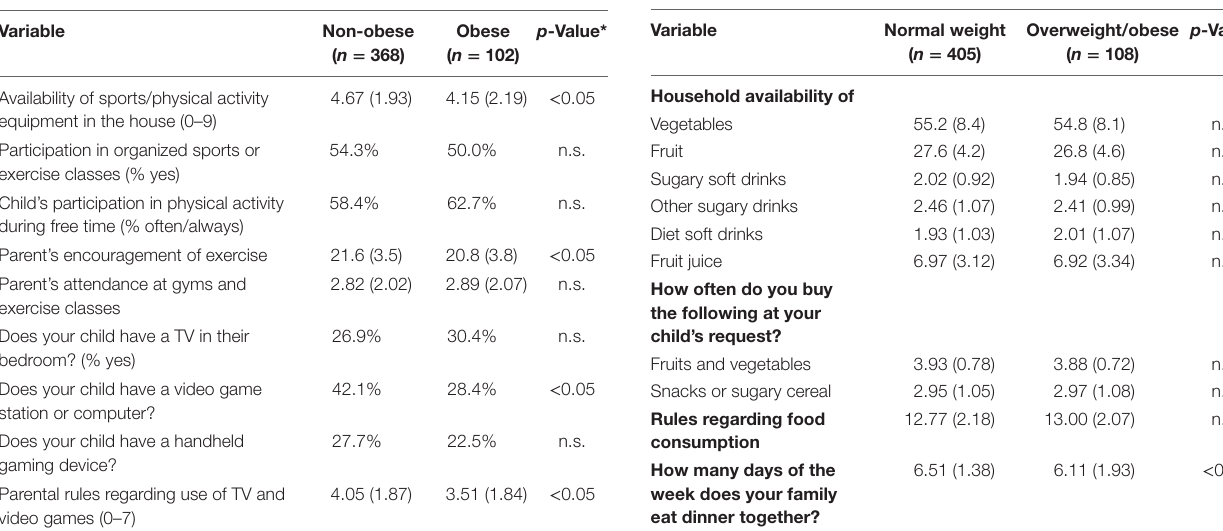
TaBle 3 | nutrition-related variables by child’s obesity classification.